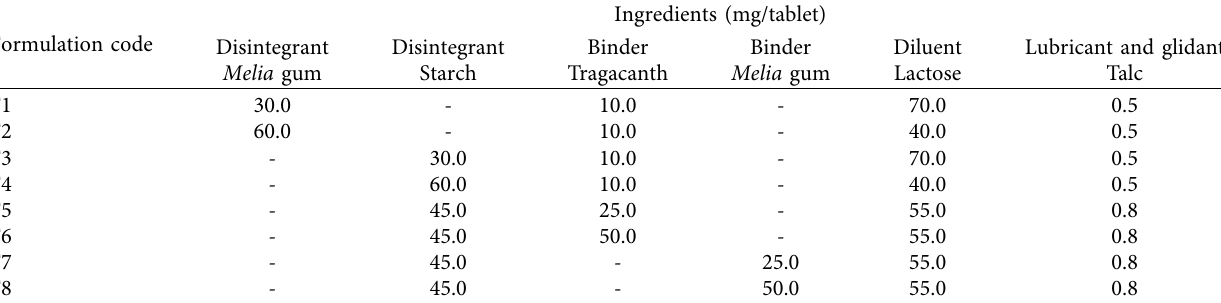
Table 1: Master formula for preparation of